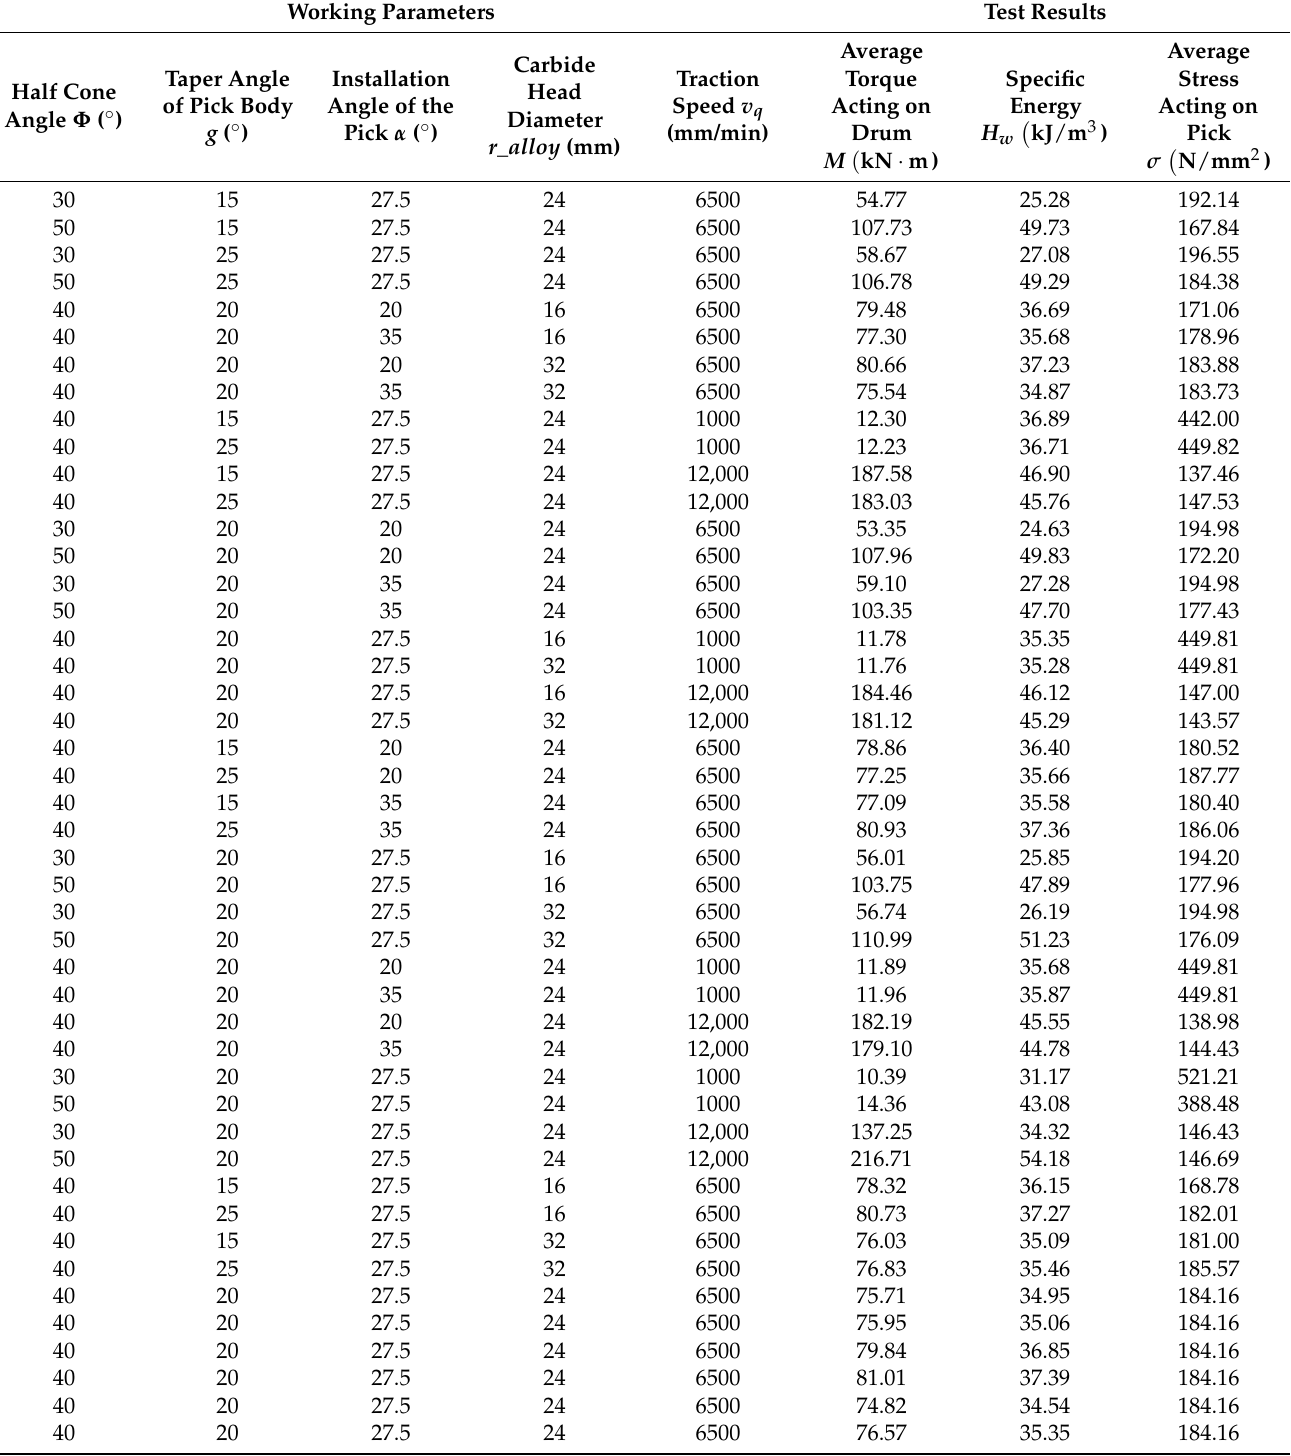
Table 1. The scenarios and results of numerical